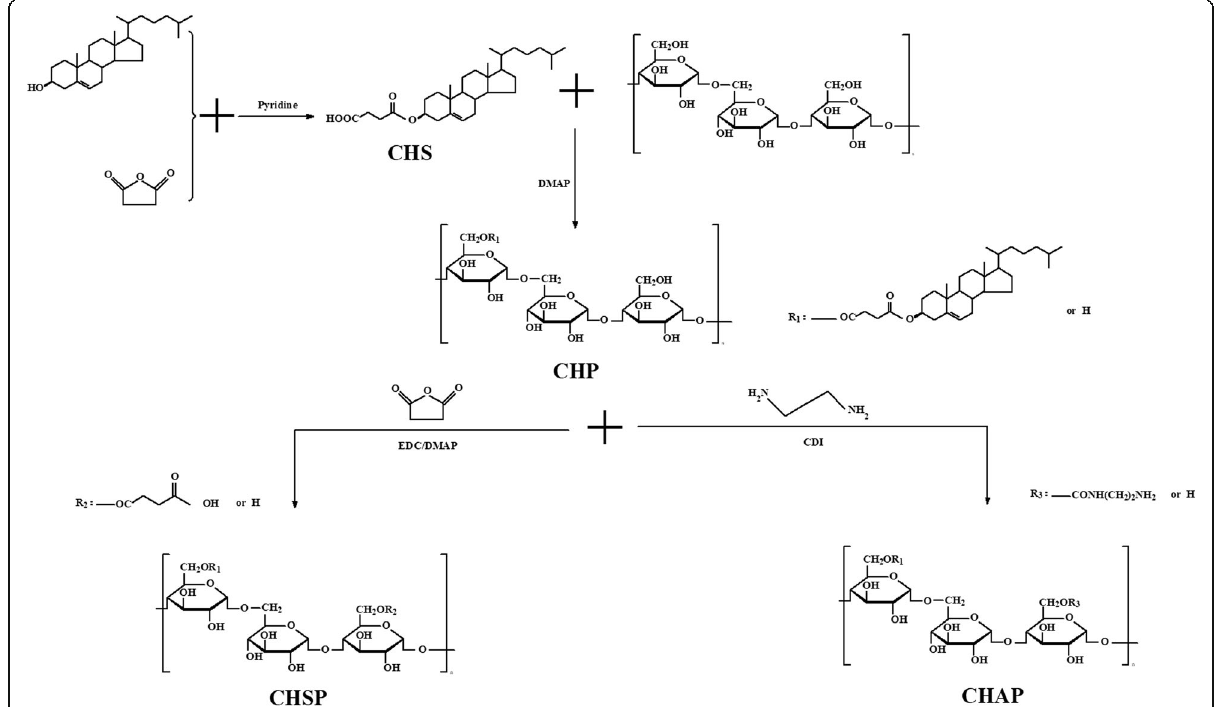
Fig. 1 Synthesis of CHP, CHSP, and CHAP